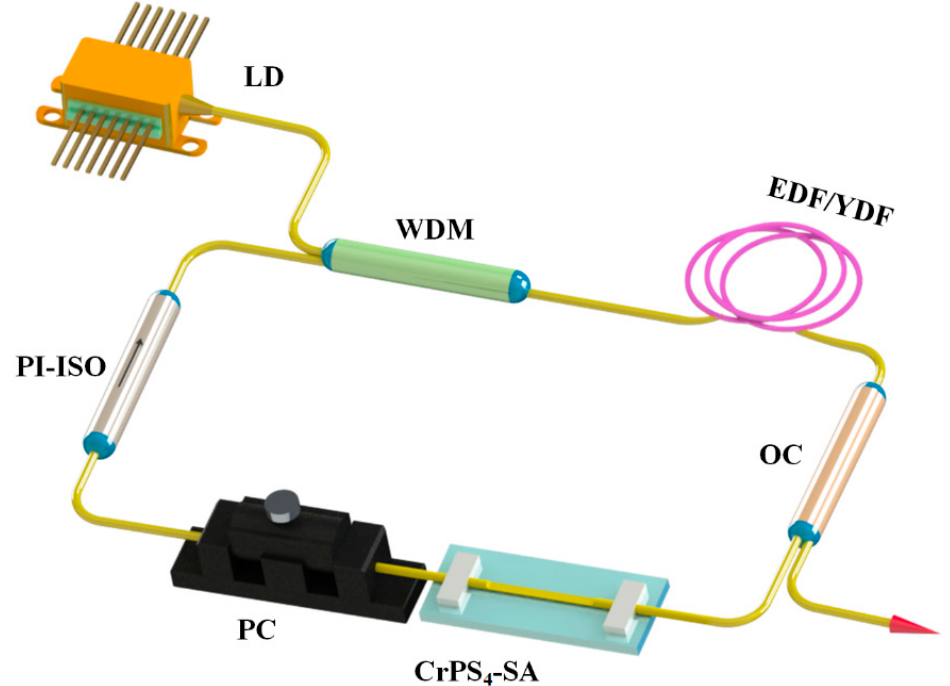
Figure 5. The cavity schematic for the fiber laser. Importantly, we performed pre-experiments to demonstrate that, in the absence of SA, no mode-locking occurred in the laser cavity, regardless of PC modulation or pump power. By such means, we confirmed the authenticity of the experiment. After SA was applied to the laser cavity, we adjusted the PC while continuously increasing the pump power, and observed the output waveform of the oscilloscope. We achieved continuous-wave mode-locking (CWML) when the pump power was higher than 170 wm. When the pump power was increased to 300 mW, the output power was 10.64 mW, and pulse energy and peak power were 1.174 nJ and 3.94 W, respectively. The mode-locking sequence diagram is presented in Figure 6a, which shows a 110.4 ns time interval between adjacent pulses, which corresponds well to the pulse repetition rate of 9.05 MHz. The inset in Figure 6a shows the amplitude intensity plot of the mode-locked pulse sequence; this indi- cates that the mode-locked sequence existed stably for a long time. The spectrum with a central wavelength of 1036.1 nm had a 3 dB spectral width of 0.84 nm, as shown in Figure 6b. The autocorrelation trace corresponding to the measured pulse at this time is shown in Figure 6c. It can be seen that the pulse width is about 298 ps, and the time-bandwidth product (TBP) is 69.9, indicating that the pulse has a serious chirp. In Figure 6d, a signal- to-noise ratio (SNR) measurement of approximately 55.3 dB can be observed with a higher signal peak at a laser cavity repetition rate of 9.05 MHz. The relationship between the mode-locked output power and pump power is shown in Figure 6e. When the pump power was 130 mW, the laser cavity output a continuous wave (CW). When the pump power was increased to 170 mW, the output was CWML, and the measured slope effi- ciency was about 4.9 %. Subsequently, we measured the output spectrum of the laser cav- ity over a longer timescale, at time intervals of 1 h, for a total of 6 h. As shown in Figure 6f, the long-term spectrum was quite stable, indicating that a ytterbium-doped laser has the potential of highly stable operation.